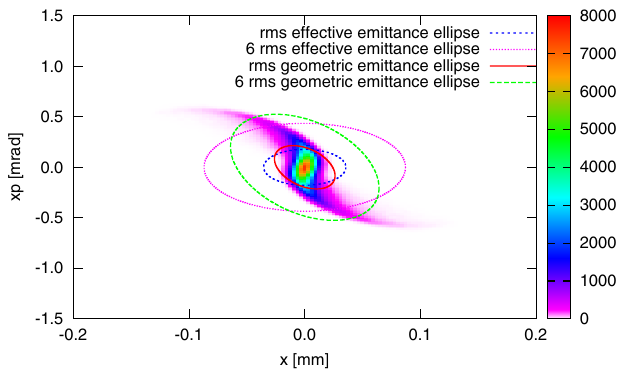
FIG. 6. (Color) Phase space distribution of the electron beam after collision for (cid:6) (cid:5) ¼ 0 : 2 m , back traced to the IP. The rms and 6 rms ellipses for both geometric and effective emittance, respectively, are